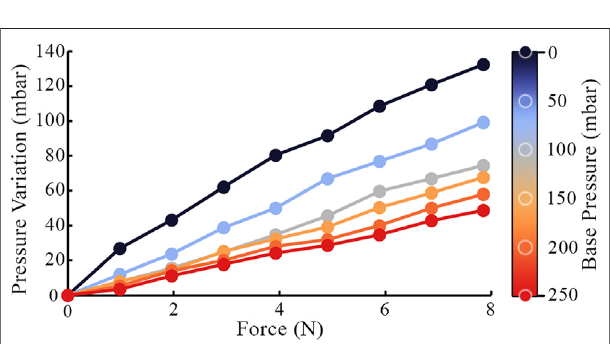
FIGURE 9 | Internal pressure variation due an external force deforming the tactile membrane. Each data series is recorded at a different baseline internal sensor